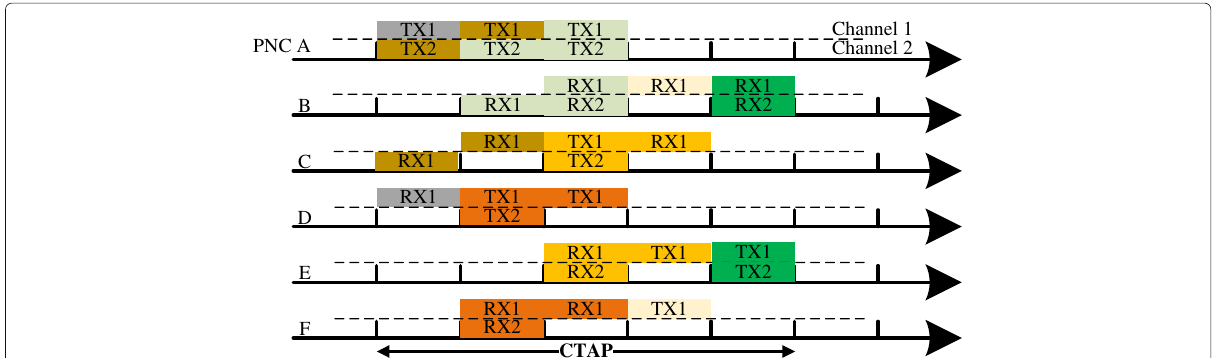
Fig. 4 An example of MPMH-MRMC operation applying the heuristic